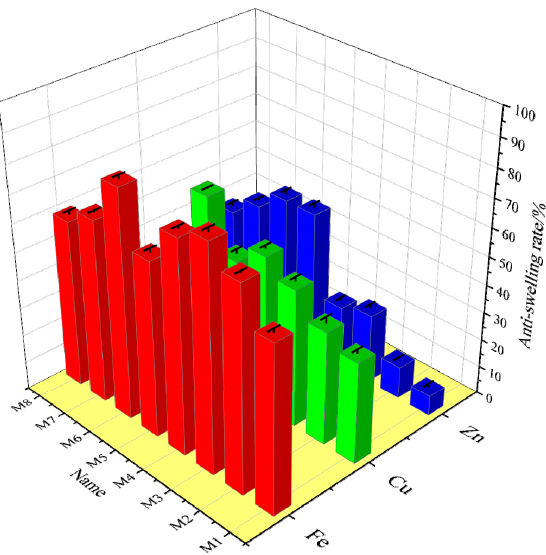
Figure 5. Curves of the linear expansion for the 4% concentrations of samples at 90 °C.